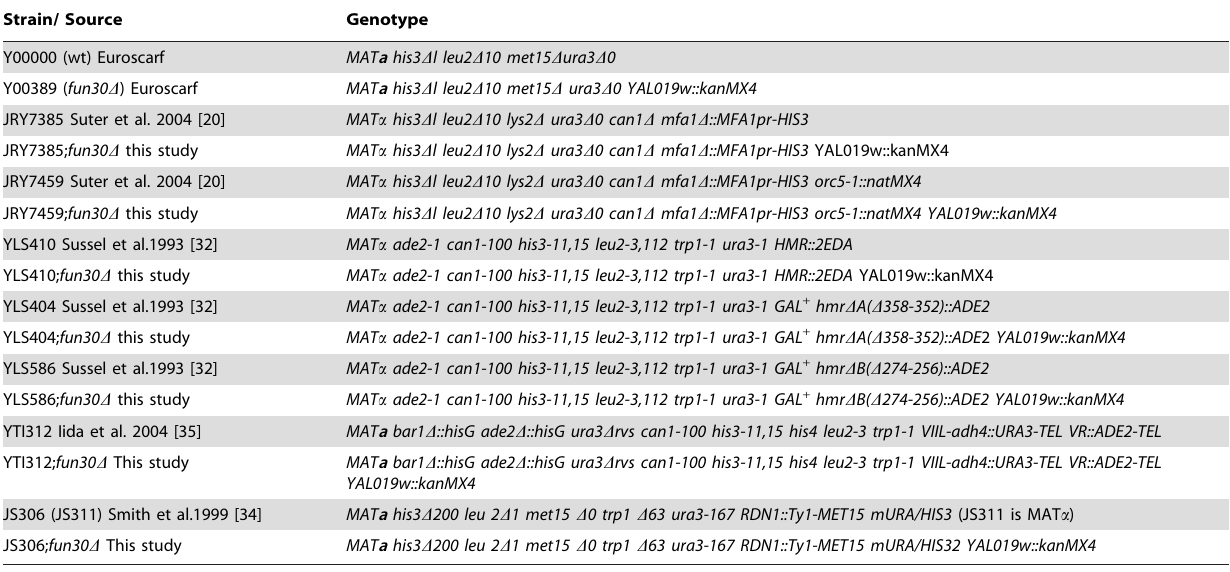
Table 2. S. cerevisiae strains used in this study.